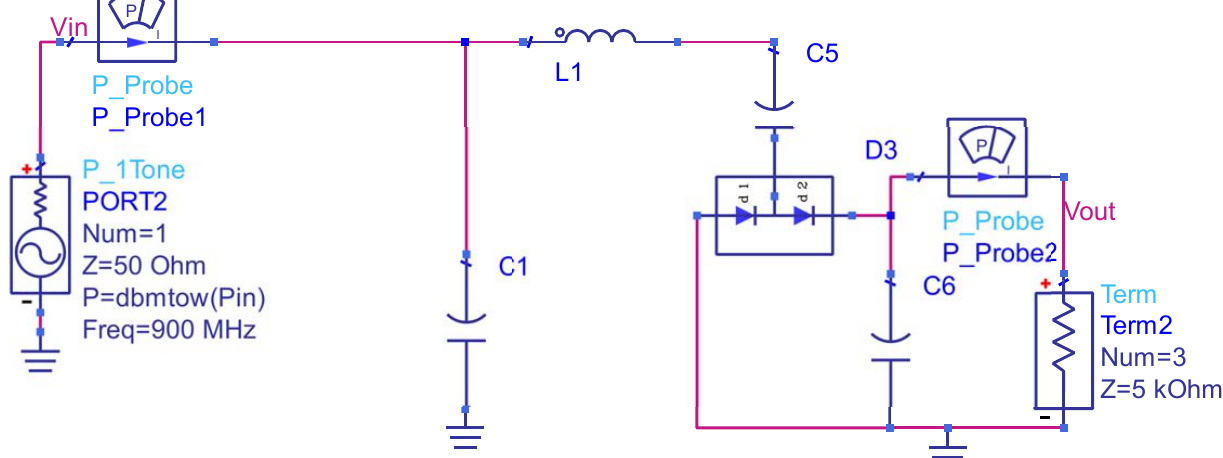
Figure 4. A matched single-band rectifier